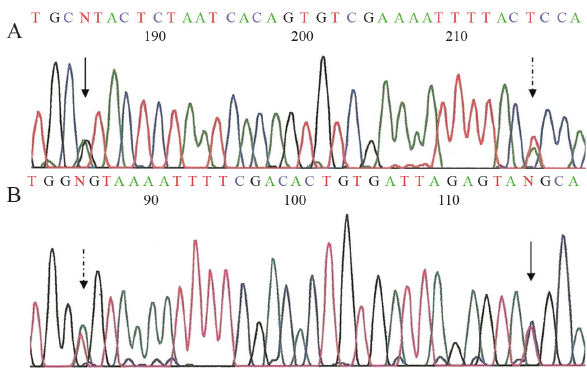
Figure 1 - Sequence electropherograms showing the complex allele [H939R;H949L] in CFTR exon 15, (A) forward and (B) reverse (Forward primer: TCAGTAAGTAACTTTGGCTGC; Reverse primer: CCTATTGATGGTGGATCAGC). Continuous arrows show the H939R mutation while the dashed arrows show the H949L